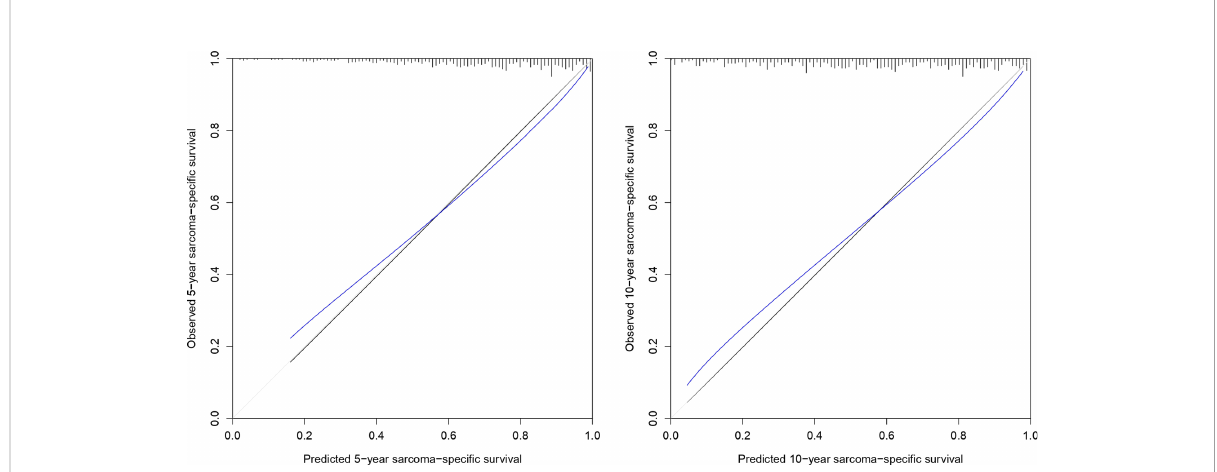
FIGURE 2 Calibration plot of 5- and 10-year sarcoma-speci fi c survival probability based on 1,000 bootstrapped resamples. Black lines indicate observed calibration, gray lines indicate ideal calibration, and blue lines indicate optimism-corrected